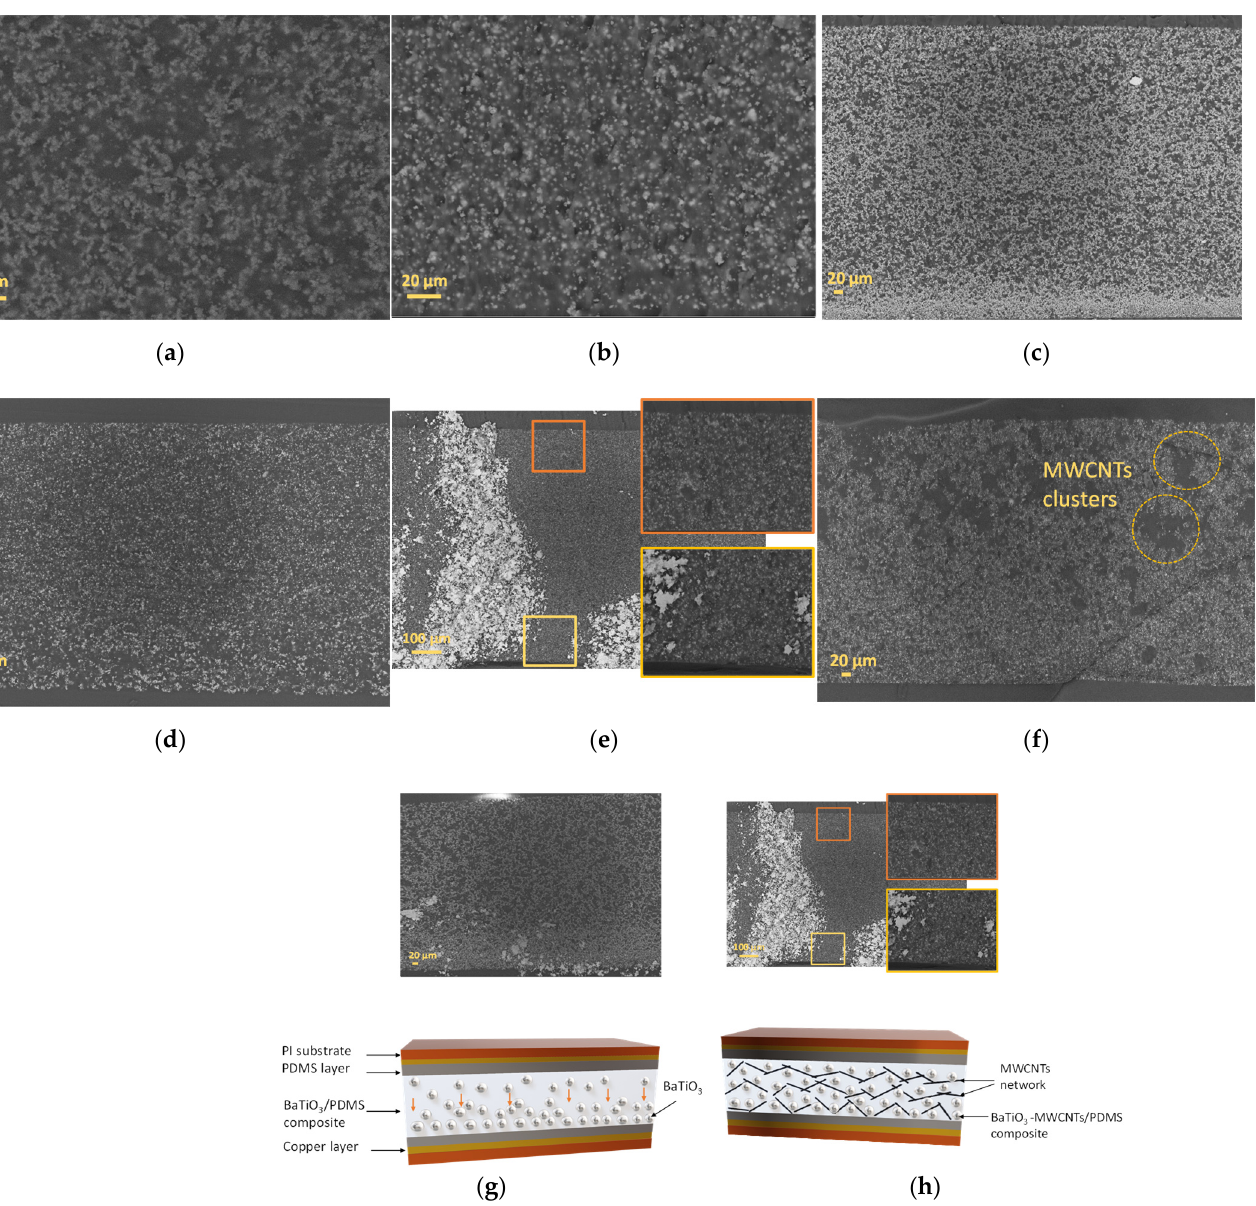
voltage and ( b ) output power.